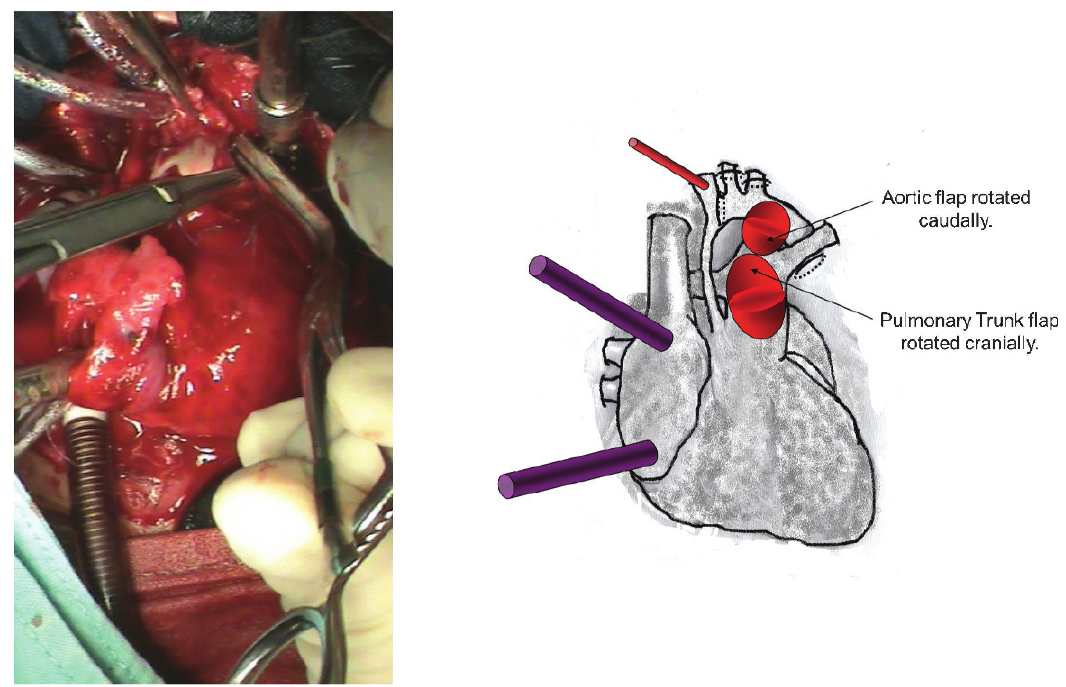
Figure 3 - A photograph and diagrammatic schema. The aortic flap was rotated caudally, and the pulmonary trunk flap was rotated cranially. These flaps were sutured edge-to-edge with 7-0 Prolene, originating the autologous posterior wall of the